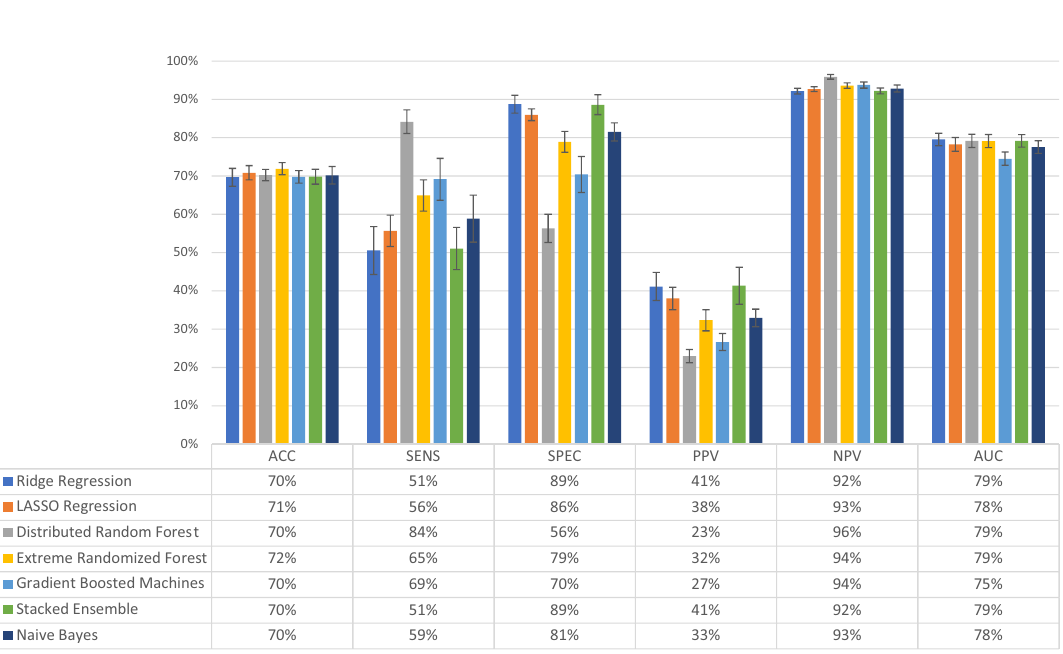
Figure 1. Evaluation of model performance in the dataset containing only background, medical and pregnancy-related variables (n = 4277 women). The models tested were Ridge Regression, LASSO Regression, Distributed Random Forest, Extremely Randomized Trees, Gradient Boosted Machines, Stacked Ensemble, and Naïve Bayes. Models were assessed for accuracy (ACC), sensitivity (SENS), specificity (SPEC), positive predictive value (PPV), negative predictive value (NPV), and area under the curve (AUC), the outcome being depressive symptoms at 6 weeks postpartum. The bars represent the level of performance measures (in percent) and the table below the bar plot presents the exact numerical values. Error bars represent one standard deviation from the